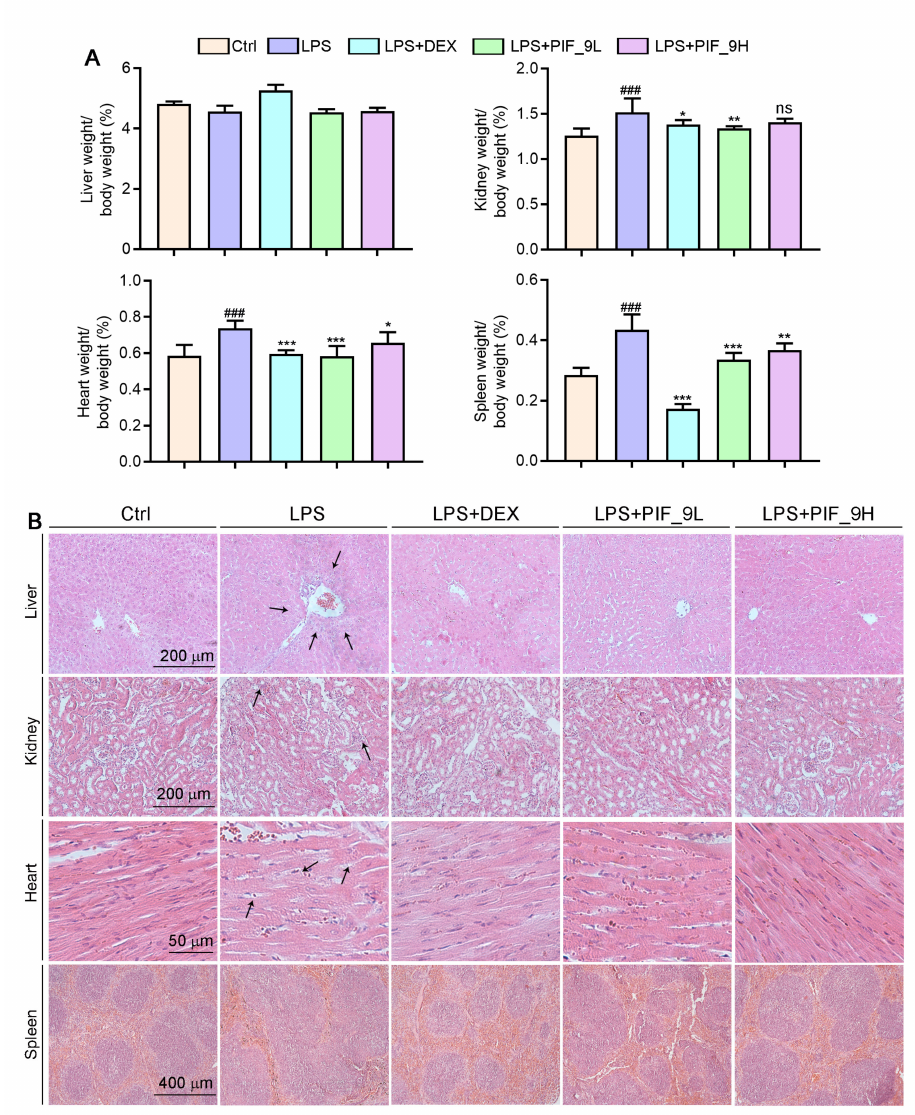
Figure 6. Compound PIF_9 improved multiple tissues damage in sepsis mice. ( A ) At the end of the experiment, liver, kidney, heart, and spleen tissues were collected and weighted and the ratio of tissue weight to body weight was calculated. ( B ) Measurements of 5- µ m paraffin sections of liver, kidney, heart, and spleen tissues were conducted using HE staining as described in Materials and Methods; the representative photographs are presented. The black arrows indicate tissue damage. ### , p < 0.001 vs. Control group; *, p < 0.05, **, p < 0.01, ***, p < 0.001 vs. LPS group ( n = 6). ns, no significant